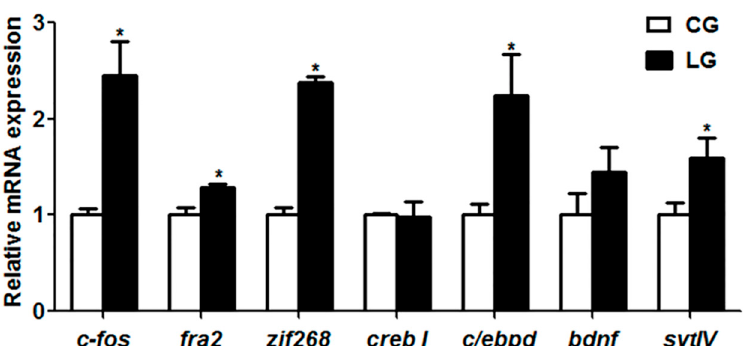
Figure 2. Learning-relative genes expression in mandarin fish (CG) with the negative demonstration fish (wild mandarin fish without training) and fish (LG) with the positive demonstration fish (pre-trained mandarin fish which could accept dead prey fish). Data are represented as mean ± S.E.M. ( n =